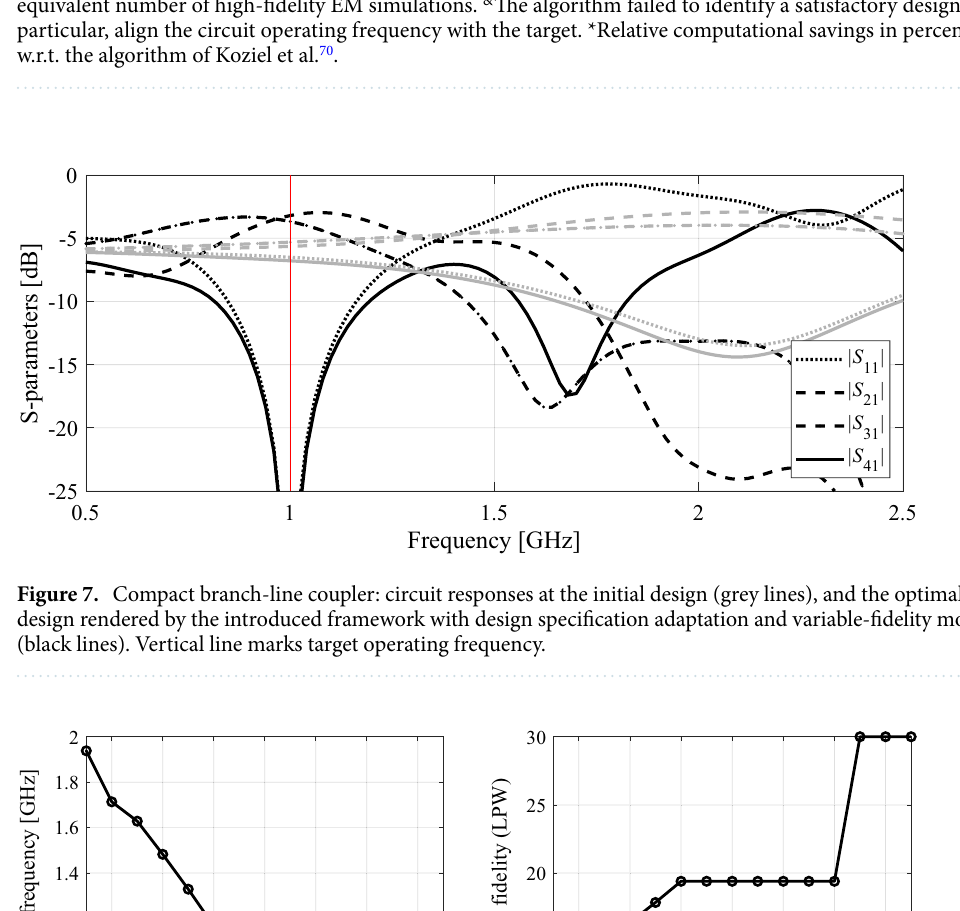
Circuit II: dual‑band branch‑line coupler.